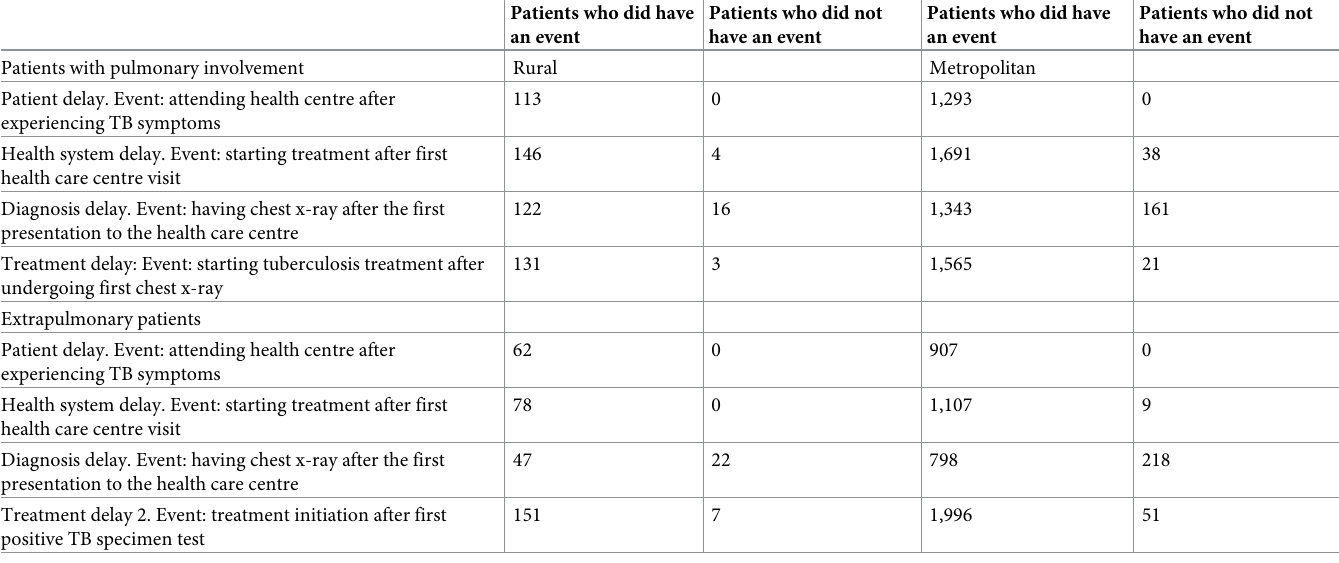
Patients who did have an event